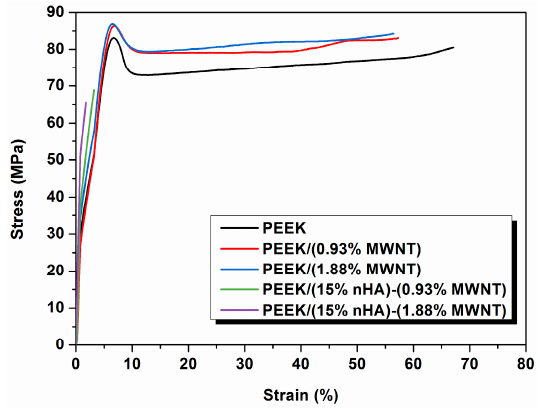
Figure 5. Tensile stress-strain curves of PEEK and its nanocomposites. Table 3. Tensile properties of PEEK and its nanocomposites.